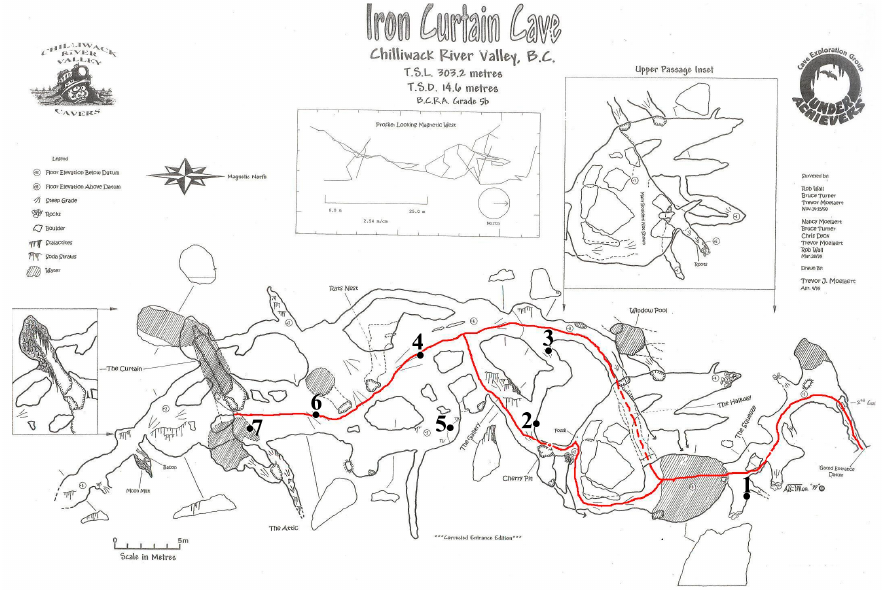
Figure 1. Map of Iron Curtain Cave in Chilliwack B.C. The numerals denote the locations of sampling points where media plates were left for nine months. #1 = Connection Room; near Squeeze dig around and Looking Pool, #2 = Upper section of The Gallery, near the climb to the Breakdown room, #3 = Entrance to side passage across from the Chocolate waterfall, #4 = Sitting area just beyond Lollipop Passage, #5 = Octopus Room, #6 = Mid passage to the Curtain, just past the Wishing Well, #7 = Chandelier Pit just below The Attic.